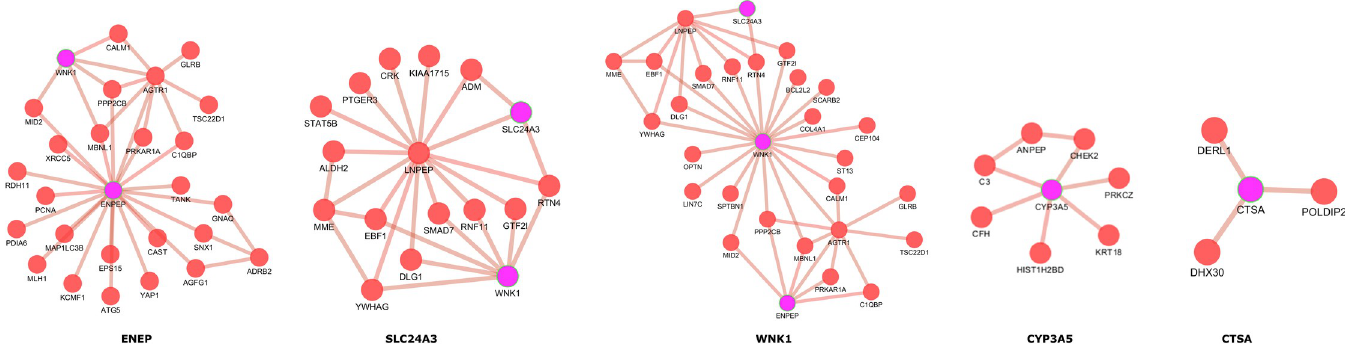
Fig 6. The partners of prioritized unreported salt sensitive genes (ENPEP, WNK1, CYP3A5, SLC24A3 and CTSA) which are co-expressed with obesity related genes in obese condition.